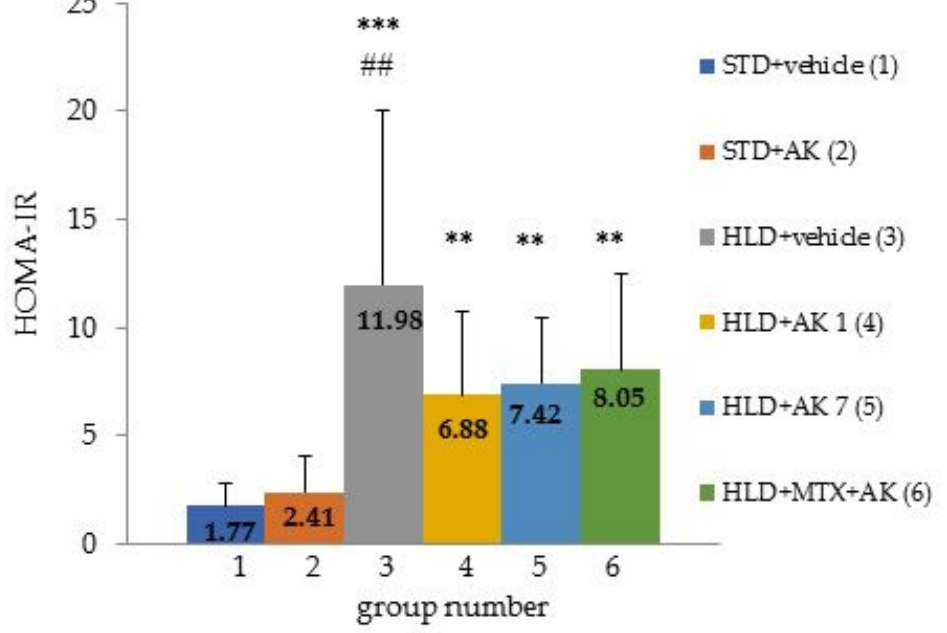
Figure 1. HOMA-IR in C57Bl/6 mice fed an STD (Groups 1, 2) or a HFD (Groups 3, 4, 5, 6). Data are presented as group mean + standard deviation. ** р ≤ 0.01, *** р ≤ 0.001 relative to group 1 (STD +